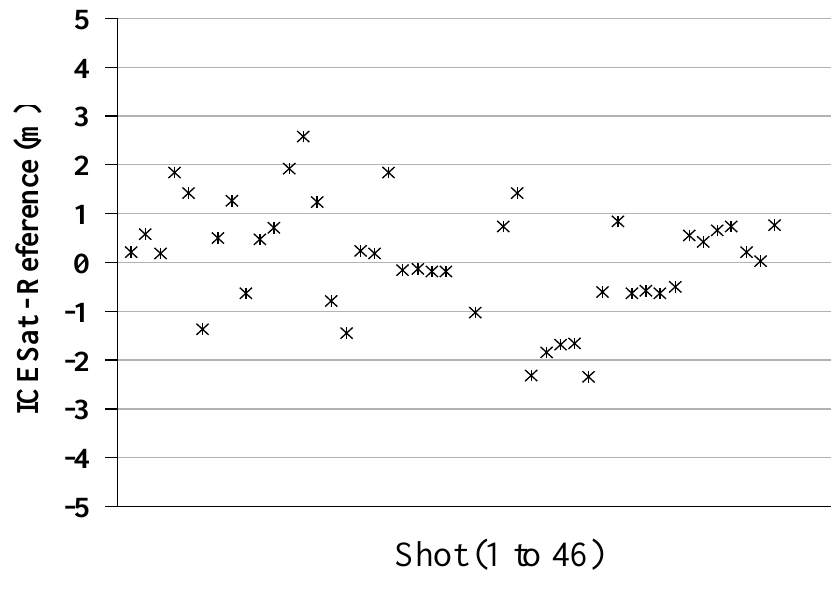
Figure 6. Difference between GLAS and hydrological stations elevations (reference) for French rivers. Each point corresponds to one footprint (for a total of 46